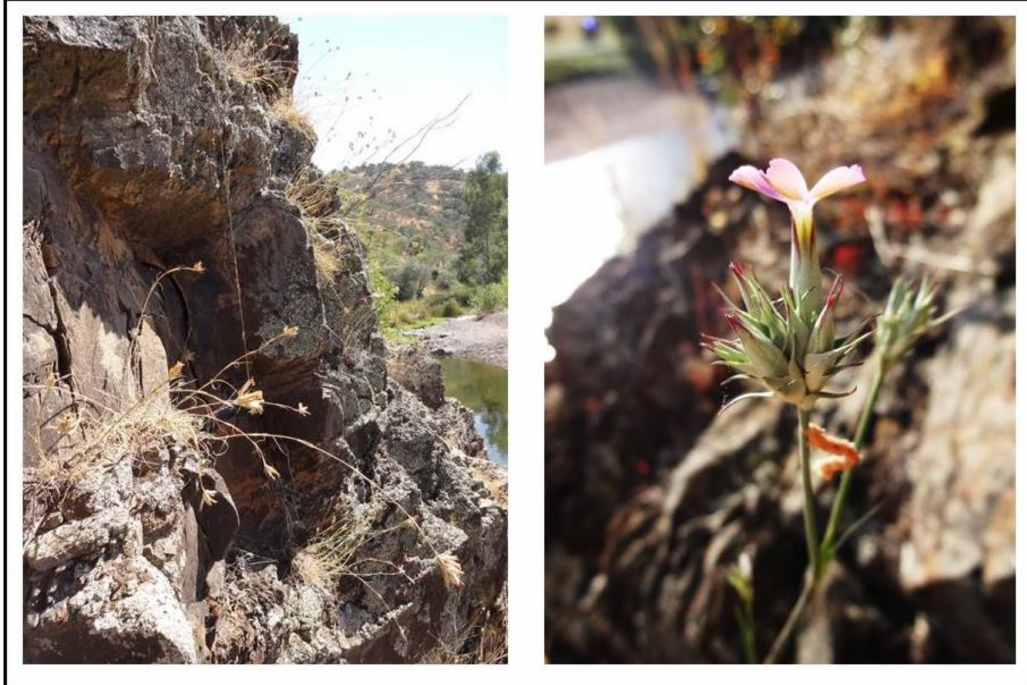
Figure 3. Sanguisorbo rupicolae-Dianthetum crassipedis on rocky cliff fissures in the lower Guadiana basin (Ribeira da Foupanilha, near Vaqueiros—Alcoutim), included in the southwestern part of the Mari á nica Range